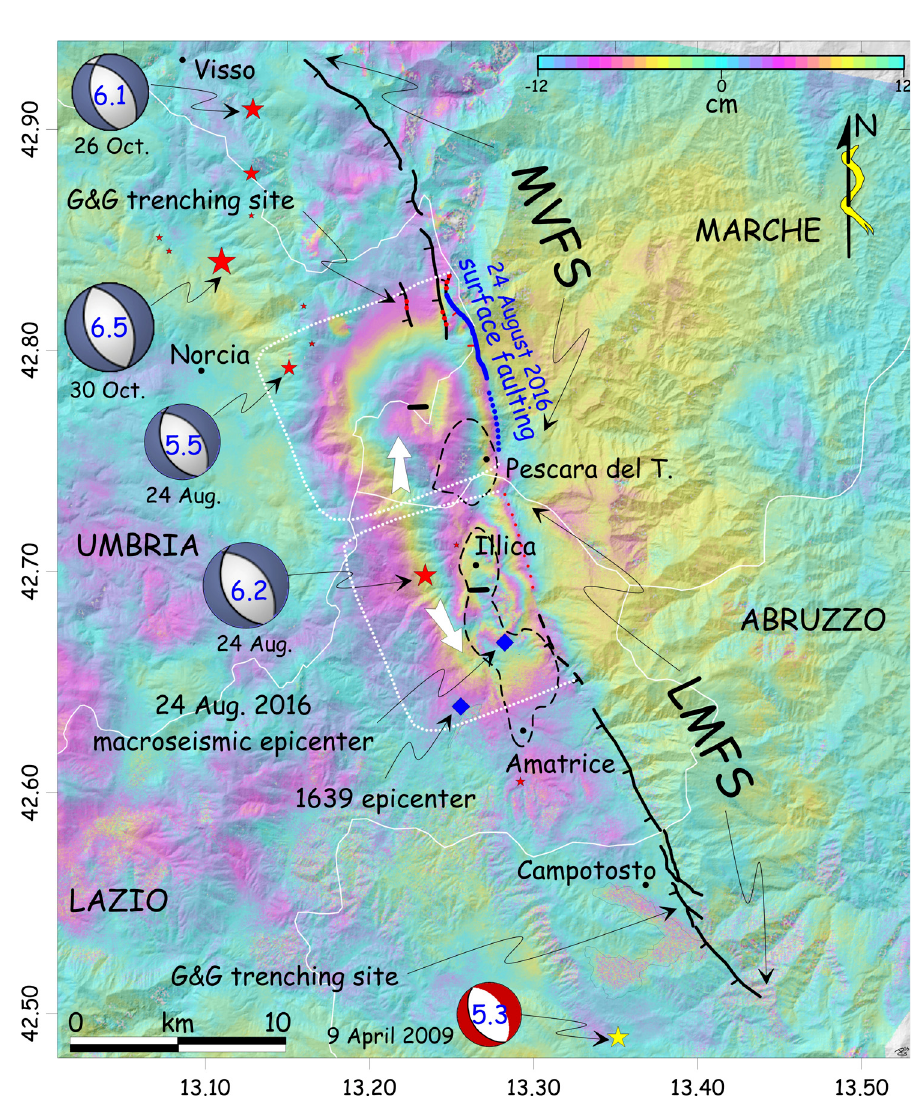
Figure 4. Interferogram processed by GSI [2016] using ALOS-2/PALSAR-2 data (displacement between satellite and ground in cm; date 25 May 25 and 31 August 2016. Descending flight direction). The two mi- nus signs indicate about 20 cm of coseismic subsidence. Dashed line, 9 MCS isoseismal. Red stars, M >4 L events [ISIDe 2016]; yellow star, 9 April 2009 event. MVFS, Mount Vettore fault system; LMFS, Laga Mounts fault system [G&G=Galadini and Galli 2003]. Blue line (blue/red dotted where discontinuous) is the surface break/faulting of the 24 August 2016 earthquake (white dotted line, fault area at depth). White arrows suggest the two rupture propagations of the M 6.2, 24 August 2016 earthquake, one northward W along the MVFS, the other southward along the LMFS. The two M 6.1 and M 6.5 occurred on 26 and 30 W W October, respectively, have been added. The M 6.5 event generated up to 2 m of surface faulting all along W the